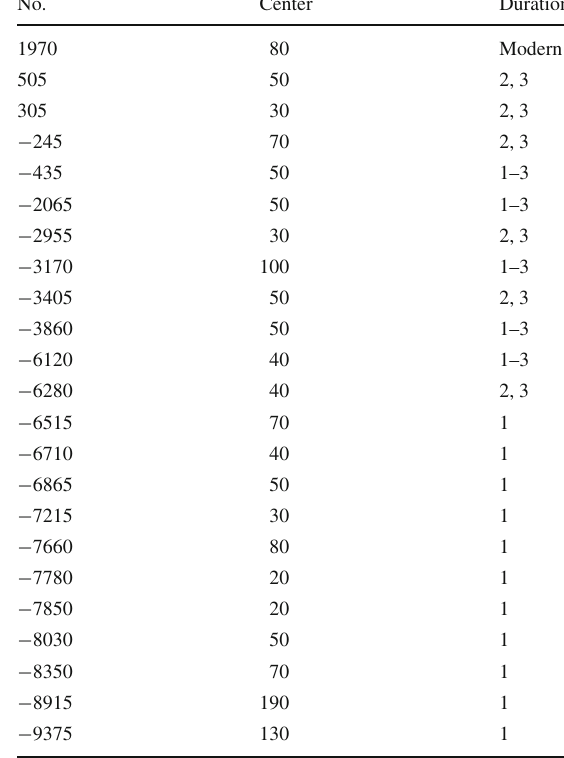
of grand maxima in reconstructed solar